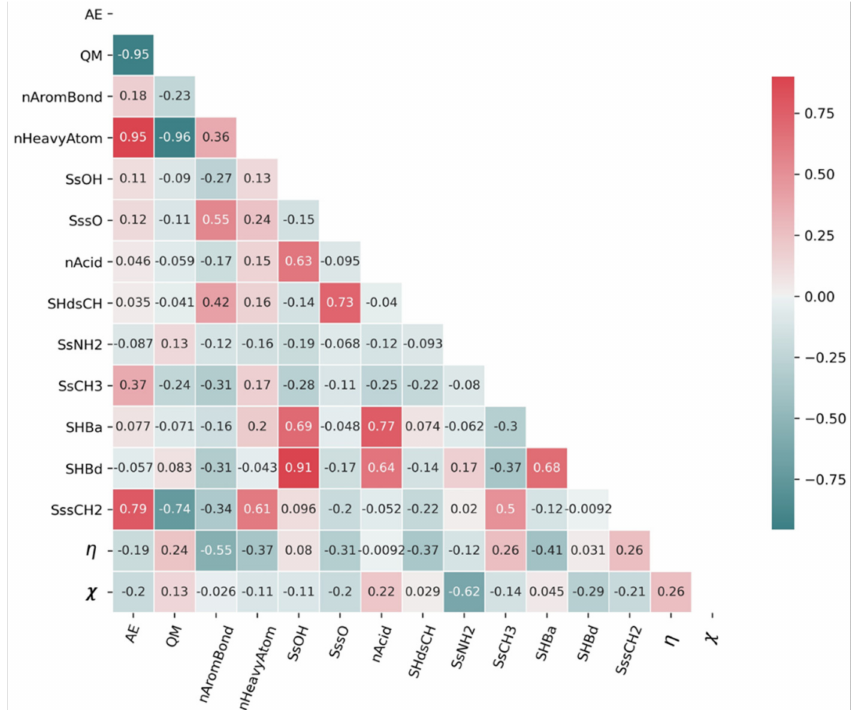
Figure 3. Correlation coefficients among 15 descriptors. AE: atomization energy, QM: quadrupole moment, nAromBond: number of aromatic bonds; nHeavyAtom: number of heavy atoms (all but hydrogen); SsOH: sum of (-OH) E-States; SssO: sum of (-O-) E-States; nAcid: number of acidic groups; SHdsCH: sum of (=CH-) E-States; SsNH2: sum of (-NH2) E-States; SsCH3: sum of (-CH3) E-States; SHBa: sum of E-States for hydrogen bond acceptors; SHBd: sum of E-States for hydrogen bond donors; SssCH2: sum of (-CH2) E-States (see Supplementary Materials); η : chemical hardness; χ :